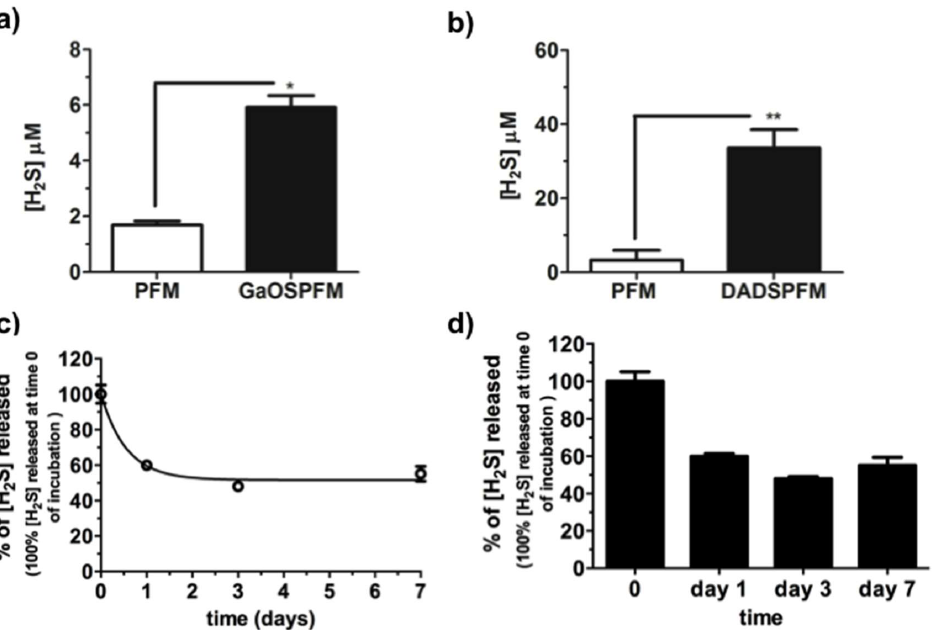
Figure 8. H 2 S release from functionalized PFM. H 2 S release from ( a ) GaOSPFM and ( b ) DADSPFM disks (1 cm of diameter) performed with 1 h of incubation at 37 °C; H 2 S release from DADSPFM disks over time, after incubation: ( c ) in buffer solution (50 mM Tris HCl, pH 8.0) at 37 °C, and ( d ) dried in petri dish at room temperature for 0, 1, 3, and 7 days. * p < 0.05; ** p < 0.02.